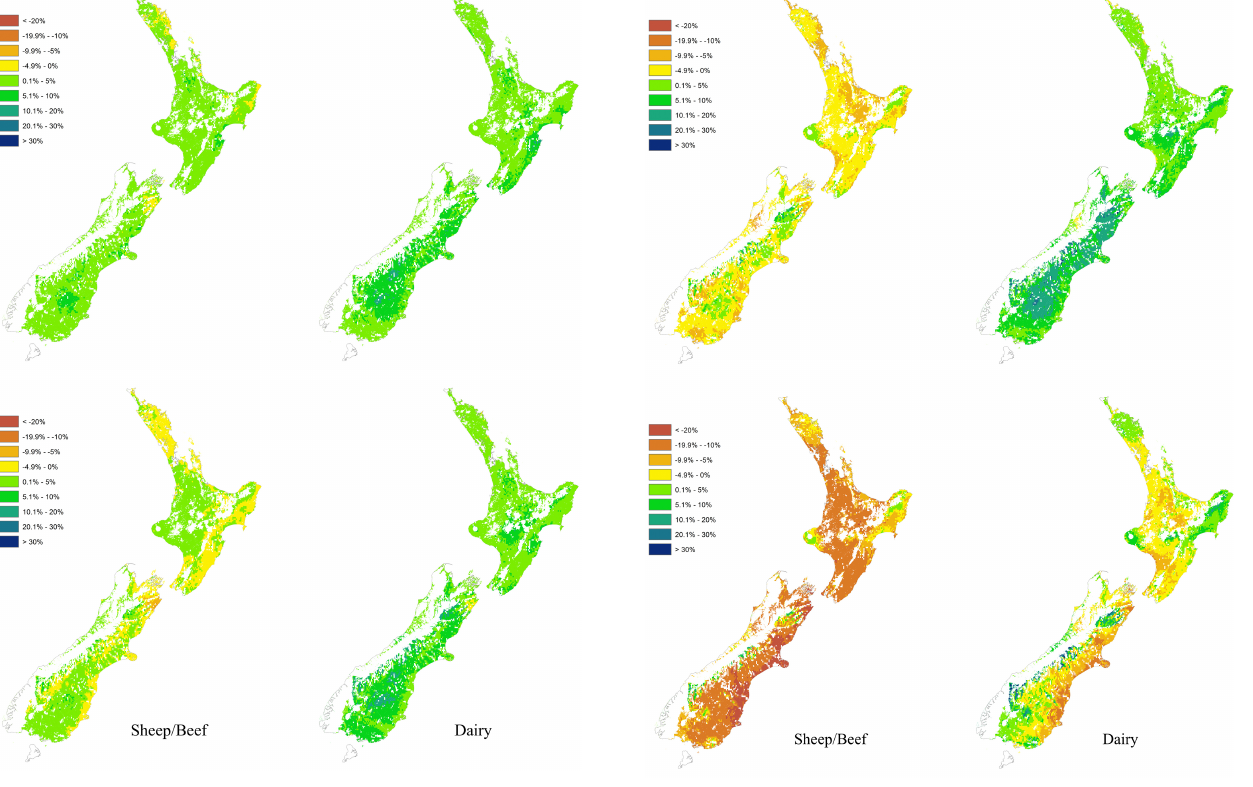
Figure 9. Climate change 2100 MPI (top) and CCC (bottom) model scenarios, average annual total pasture production, percent- age change from baseline for sheep/beef (left) and dairy (right). Each map shows national pasture production as if all of the avail- able land (excluding urban and conservation land) were devoted to sheep/beef or dairy agriculture systems and is not an actual repre- sentation of current or projected land